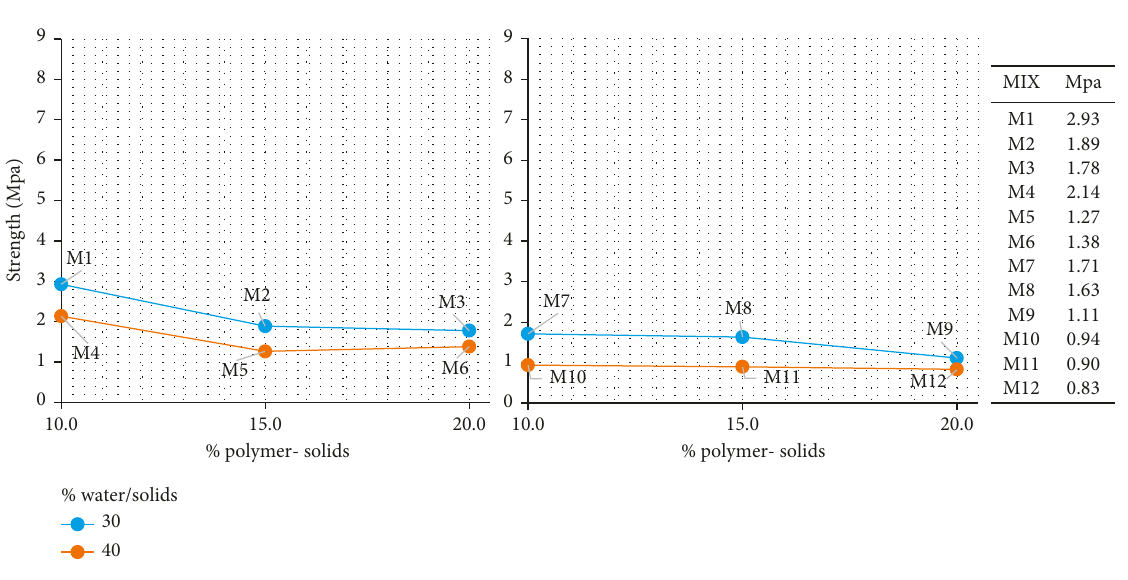
Figure 7: Compression resistance at 3 days (own